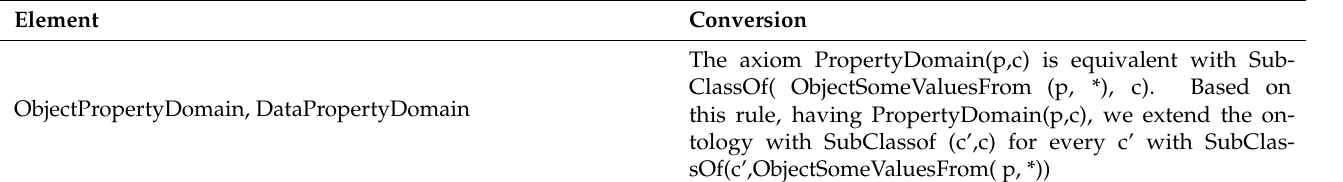
Table 4. Transformation rules used in